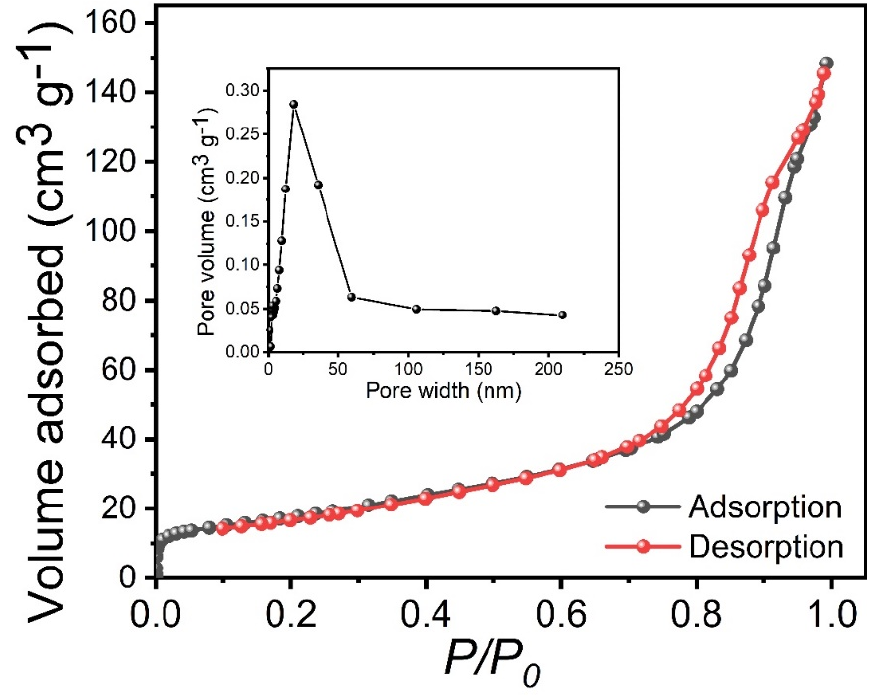
Figure 4. BET of the optimized Co 2 P 2 O 7 materials at deposition temperatures of 150 °C, inset shows the pore-size distribution of the Co 2 P 2 O 7 sample.